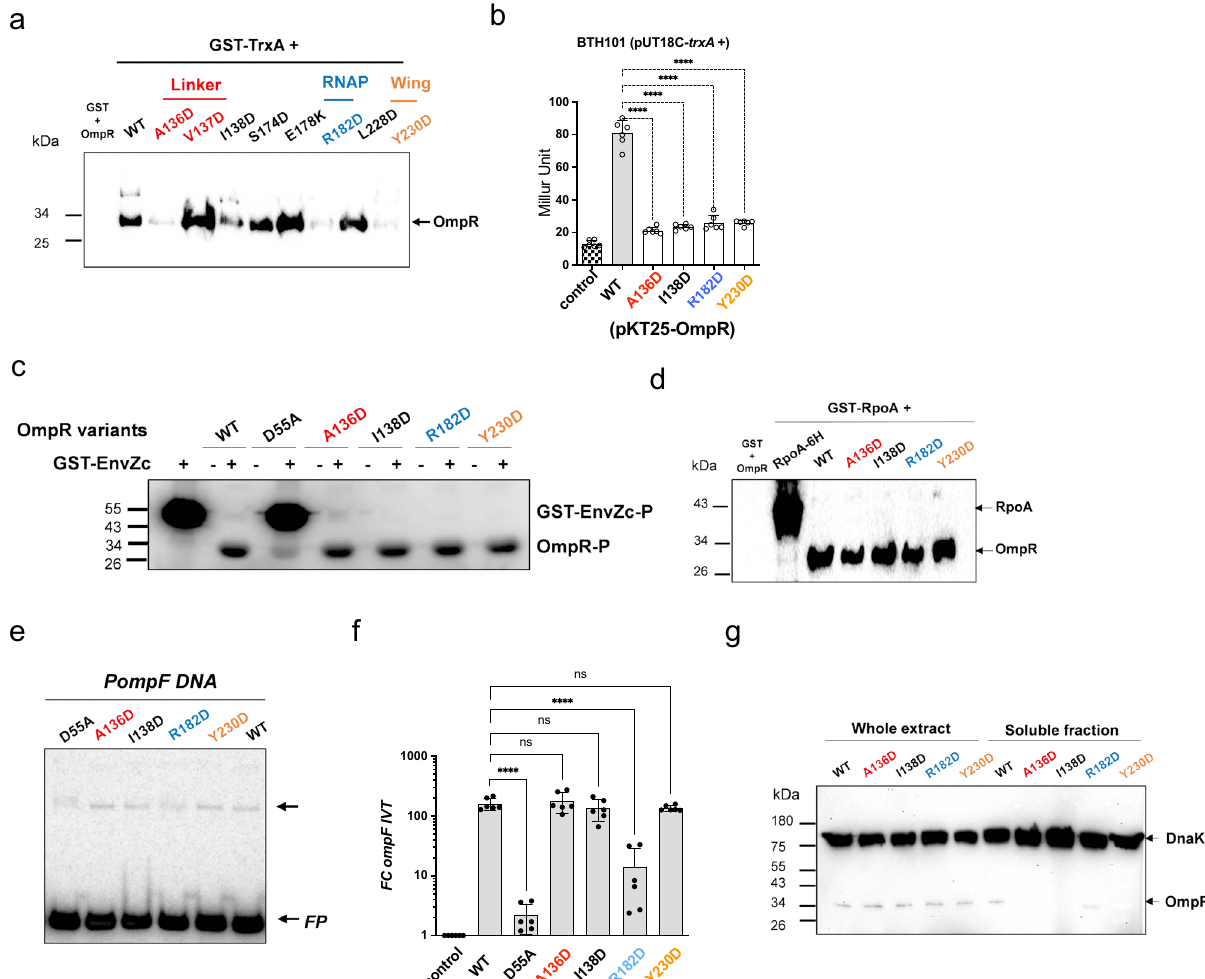
Fig. 6 | Functional characterization of the OmpR interfacial residues. a Interaction of TrxA with OmpR variants bearing mutations in interfacial residues was evaluated in biochemical pull-down assays. Recombinant OmpR-6His variants pulled-downbyGST-TrxArecombinantproteinsweredetectedbyimmunoblotting using anti-His antibodies. GST was used as a negative control. The data are repre- sentativefrom2 – 3independentexperiments. b InvivobindingofOmpRvariantsto TrxAwasevaluatedinabacterialtwo-hybridsystemin E.coli grownovernightinLB broth. The data are the mean±SD ( n =6 biological replicates) from 3 independent experiments. **** p <0.0001 as calculated by one-way ANOVA with Tukey ’ s ’ s mul- tiplecomparison test.df=5,F=224,3. c [ γ - 32 P]-ATP-dependent phosphorylation of OmpR variants by a fragment of encompassing 223-450 residues of the C-terminal cytoplasmic domain of EnvZ produced as a fusion protein with GST (i.e., GST- EnvZc)after60minofincubationatroomtemperature.PhosphorylatedOmpRand EnvZc proteins werevisualized byautoradiography. The gelis representative from 3 independent experiments. d Binding of FLAG-OmpRvariants to the GST-RpoA α - subunit of RNA polymerase was analyzed in pull-down assays. The proteins were Our structural and biochemical approaches have identi fi ed Arg 182 and Tyr 230 in the C-terminal effector domain as critical residues that mediate contact of OmpR with thioredoxin. Mutations in Arg 182 or Tyr 230 negatively impact the transcription of SPI-2 genes and attenuate Salmonella virulence. The latter phenotypes of OmpR variants bearing mutations in Arg 182 could re fl ect the previously identi fi ed function this charged residue plays in homodimer formation 38 and the herein- described role Arg 182 plays in binding to thioredoxin. Tyr 230 in the β - hairpinhaspreviouslybeenshowntomediatebindingtocognateDNA. The sidechain of Tyr 230 not only mediates interactions of OmpR with backbone phosphate groups in the major groove of cognate DNA but